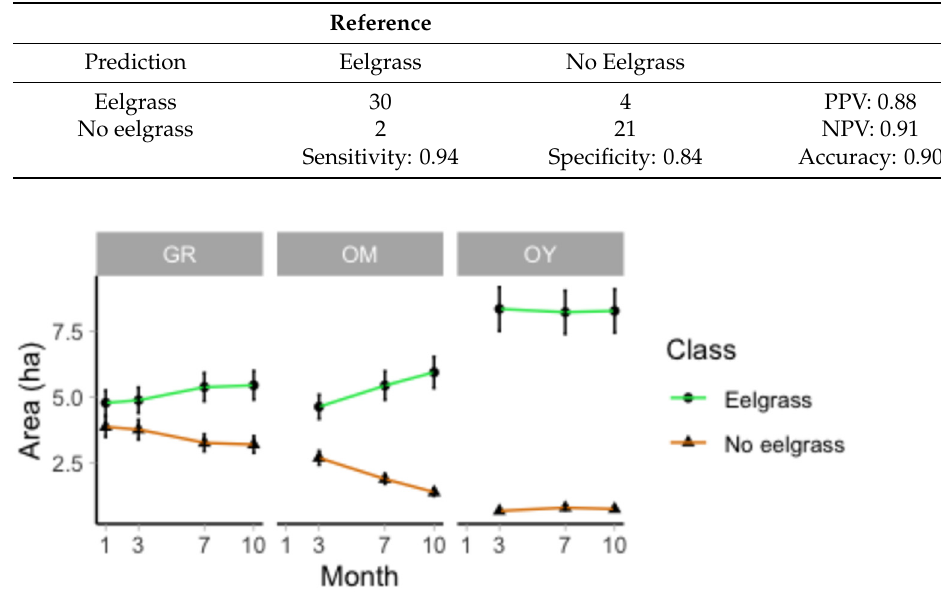
Figure 3. Area (ha) of focus sites classified as Eelgrass or No Eelgrass, for January, March, July, and October 2019 UAV surveys.